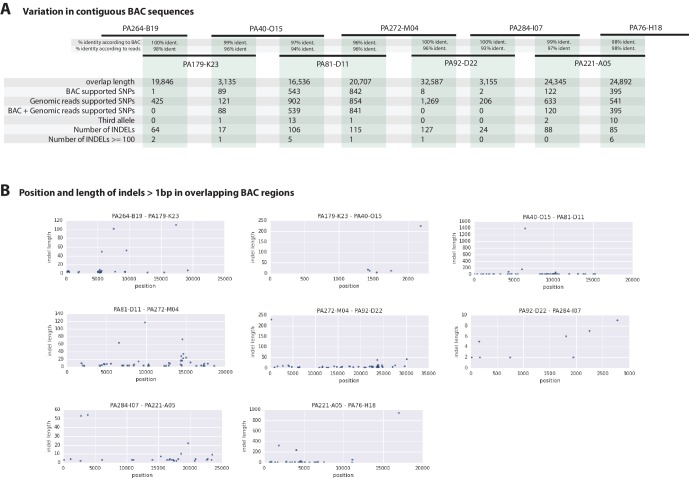
Variation observed in contiguous BAC sequences.(A) Schematic diagram of the contiguous BAC clones tiling across the HOX cluster and their% sequence identities. 'Overlap length' refers to the lengths (bp) of the overlapping regions between two BAC clones. 'BAC supported single nucleotide polymorphisms (SNPs)' refer to the number of SNPs found in the overlapping regions by pairwise alignment.'Genomic reads supported SNPs' refer to the number of SNPs identified in the overlapping regions by mapping all reads to the BAC clones and performing variant calling with GATK. 'BAC + Genomic reads supported SNPs' refer to the number of SNPs identified from the overlapping regions by pairwise alignment that are supported by reads. 'Third allele' refers to presence of an additional polymorphism not detected by genomic reads. 'Number of INDELs' refer to the number of all insertion or deletions found in the contiguous region. 'Number of INDELs >100' are insertion or deletions greater than or equal to 100. (B) Position versus indel lengths across each overlapping BAC region.